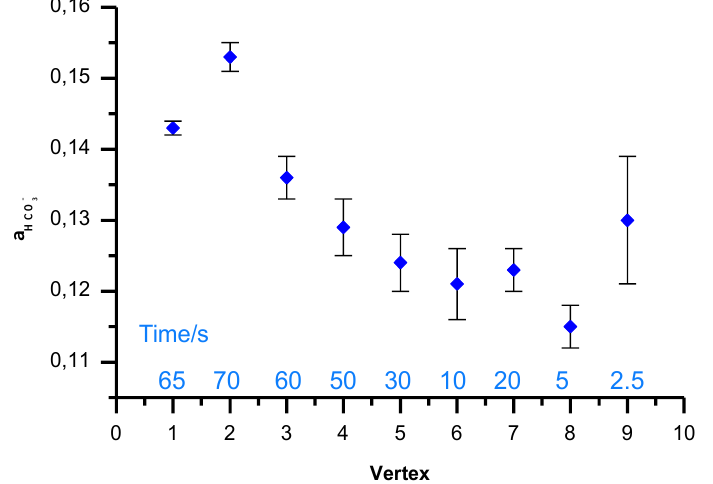
Figure 7. Minimizing the influence of chloride ion by the optimization of readout time in simplex measurements; the sample contains 25 mmol L −1 NaHCO 3 and 0.1 mol L −1 NaCl. The bars represent standard deviation for three identical electrodes.